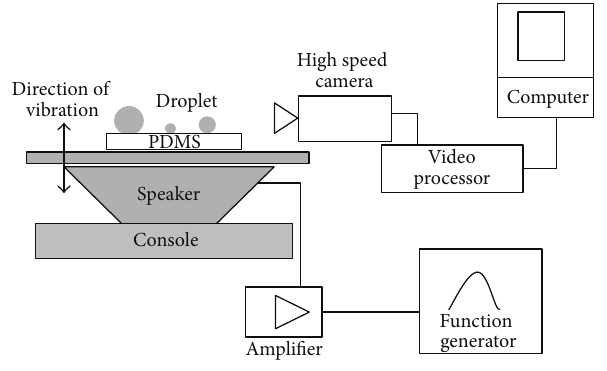
Figure 3: Experimental